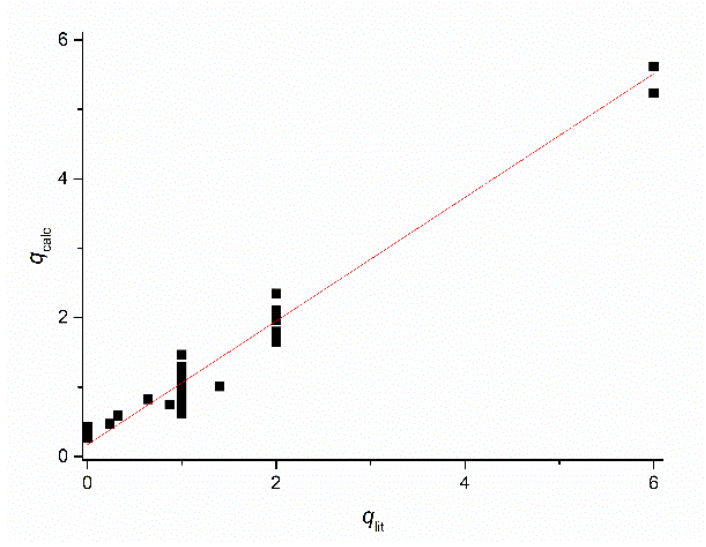
Figure 3. Plot of the hydration number for the Mn 2+ -complexes mentioned in Table 1 calculated with Equations (1) and (2) ( q calc ) versus the corresponding values reported in the literature ( q lit ).